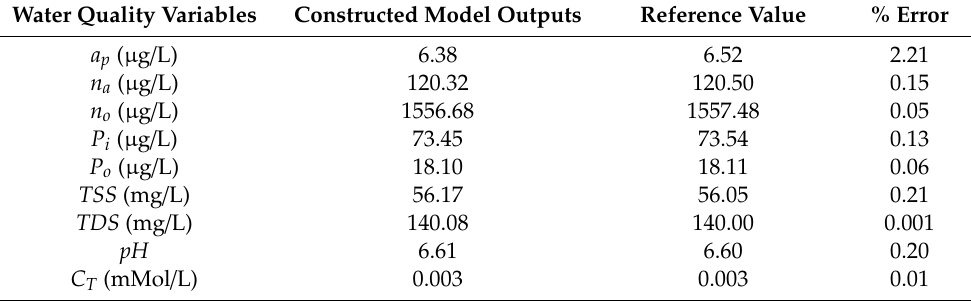
Table 4. Water quality variables calibration results for the main canal with its original